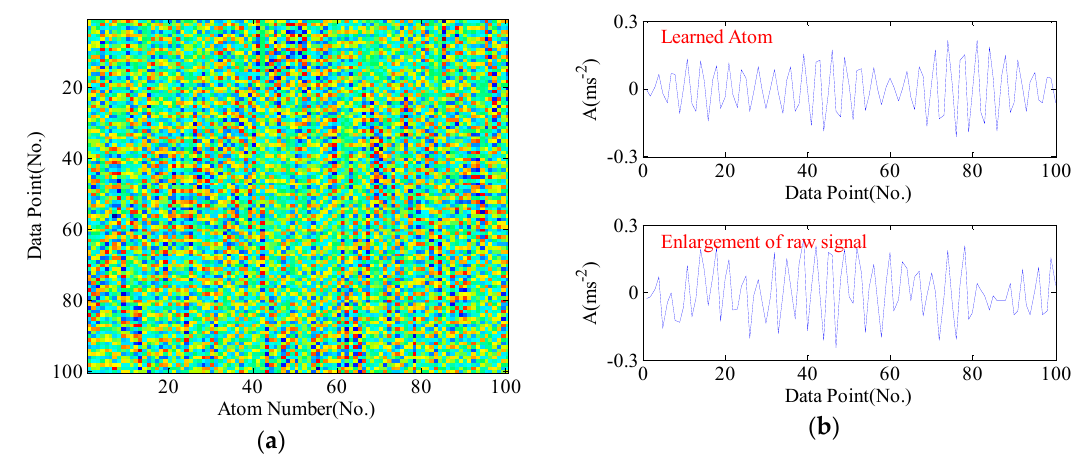
Figure 8. The learned dictionary from the sample signal of outer race fault: ( a ) the learned dictionary matrix; ( b ) the learned atom and enlargement of the raw signal.